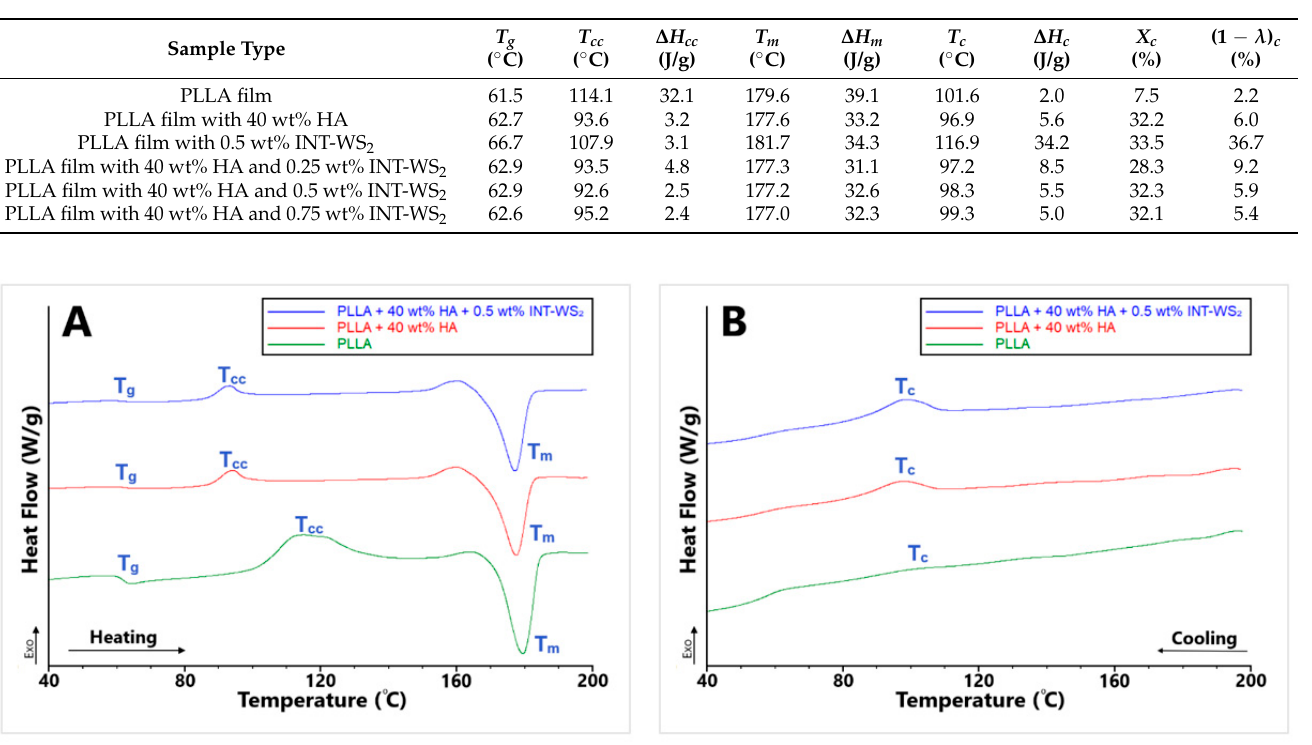
Table 4. Thermal properties of PLLA film and HA/INT-WS 2 /PLLA nanocomposites.